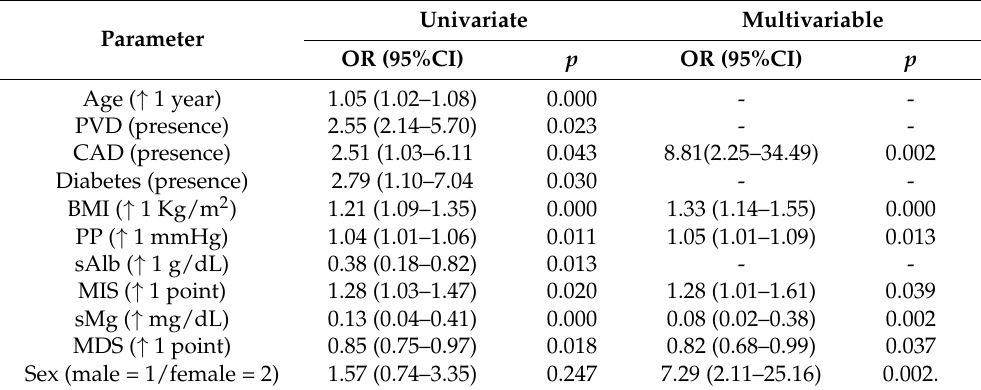
Table 3. Risk factors for left ventricular hypertrophy as assessed by multiple logistic regression analysis ( n = 127).